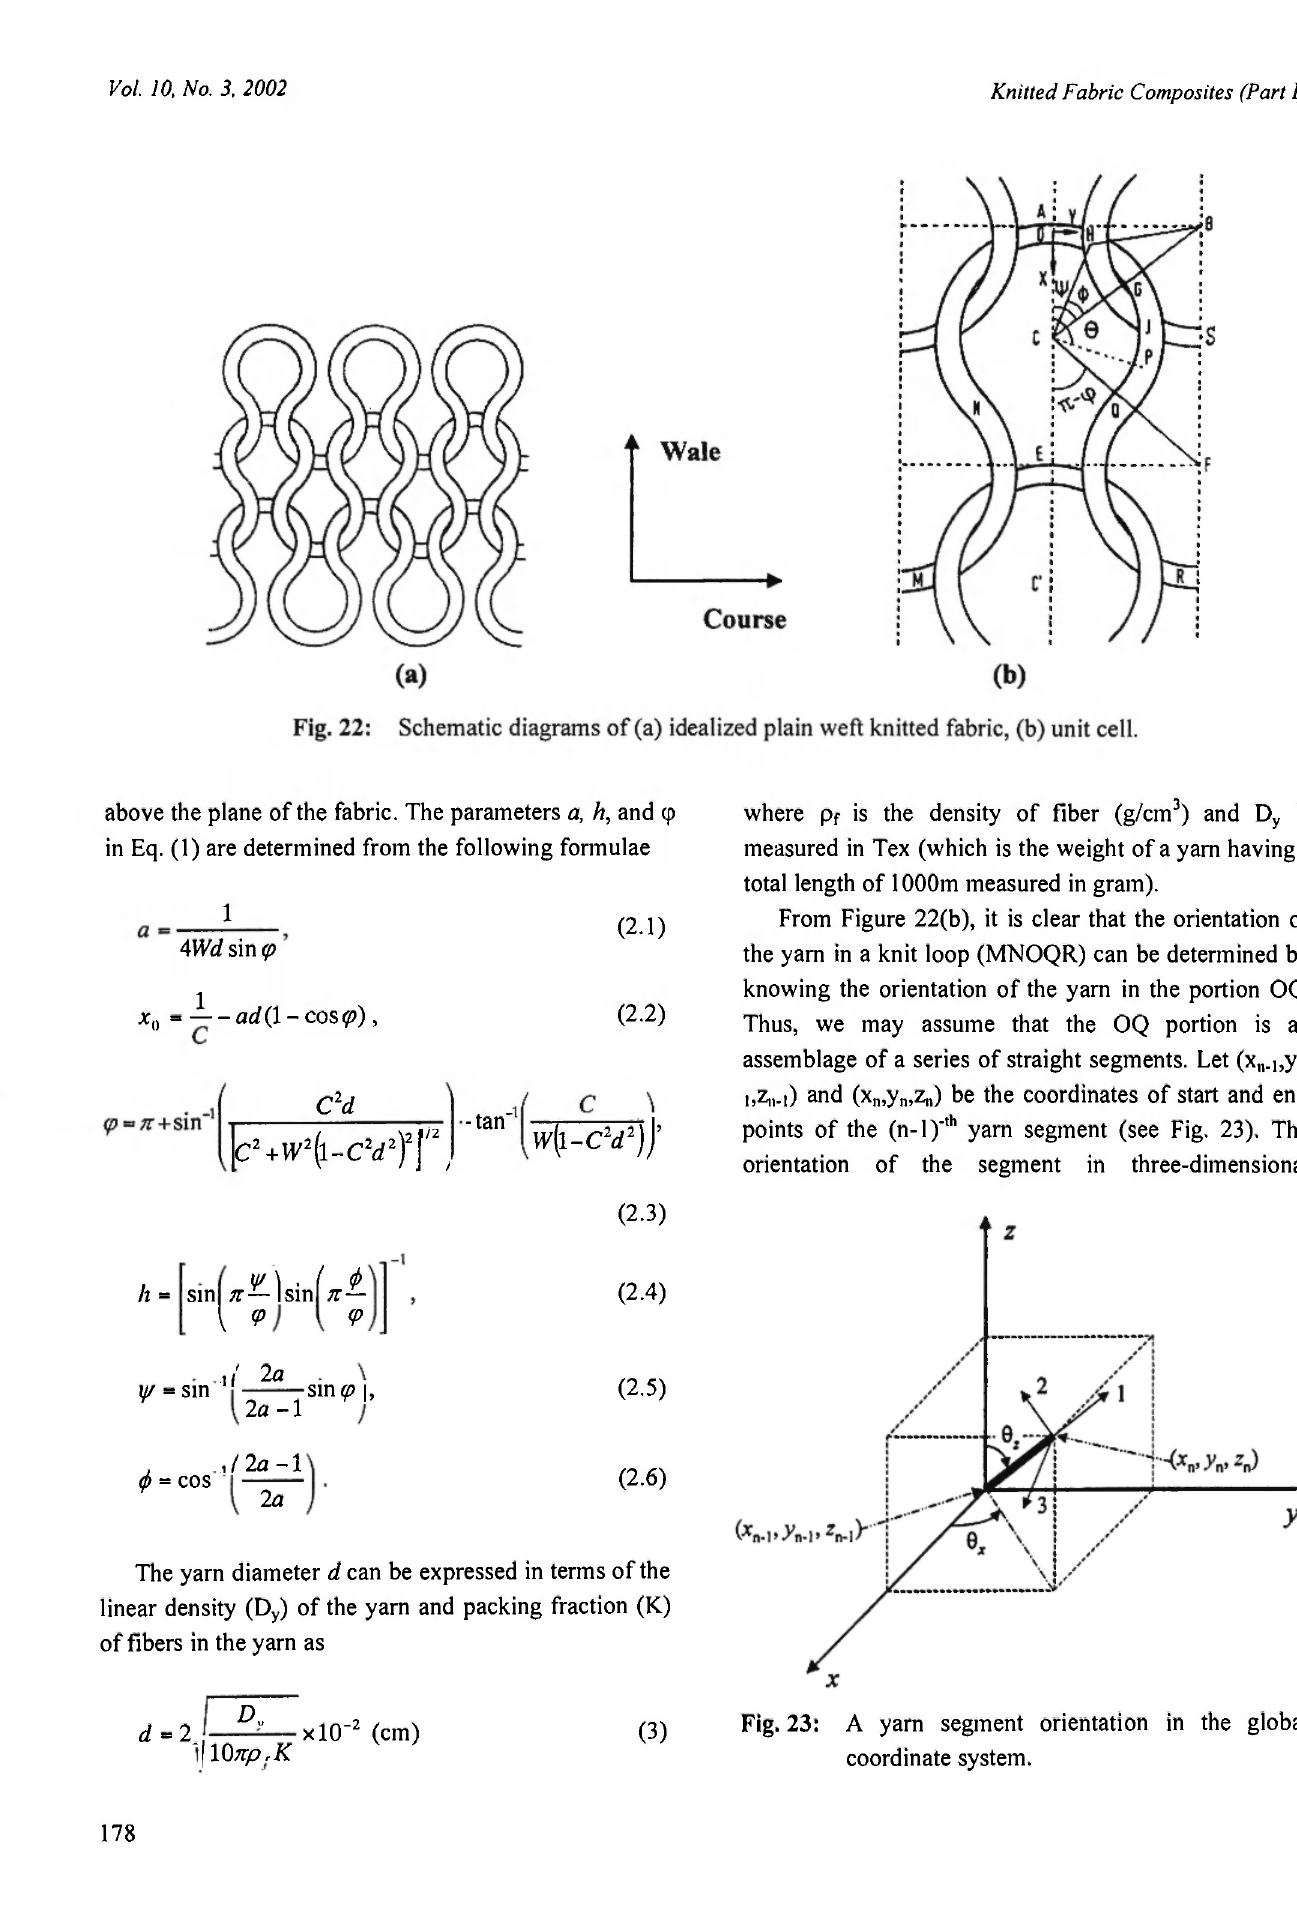
A yarn segment orientation in the global coordinate